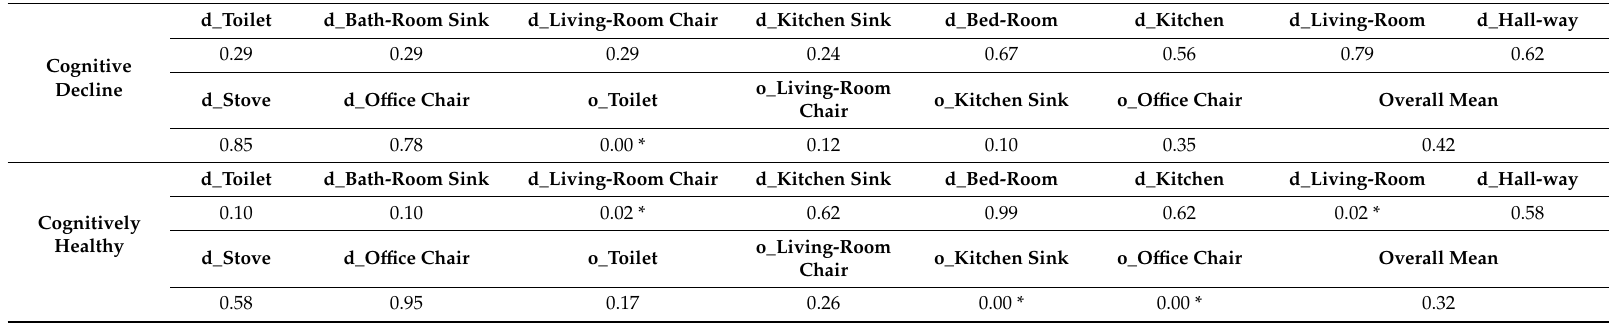
Table 6. One-way ANOVA results for between-home behavior comparisons within the same diagnosis group. Entries in blue with a standard font indicate the duration in a location, and entries in green with an italic font indicate the activity level in a location. (* = Result is statistically significant ( p <